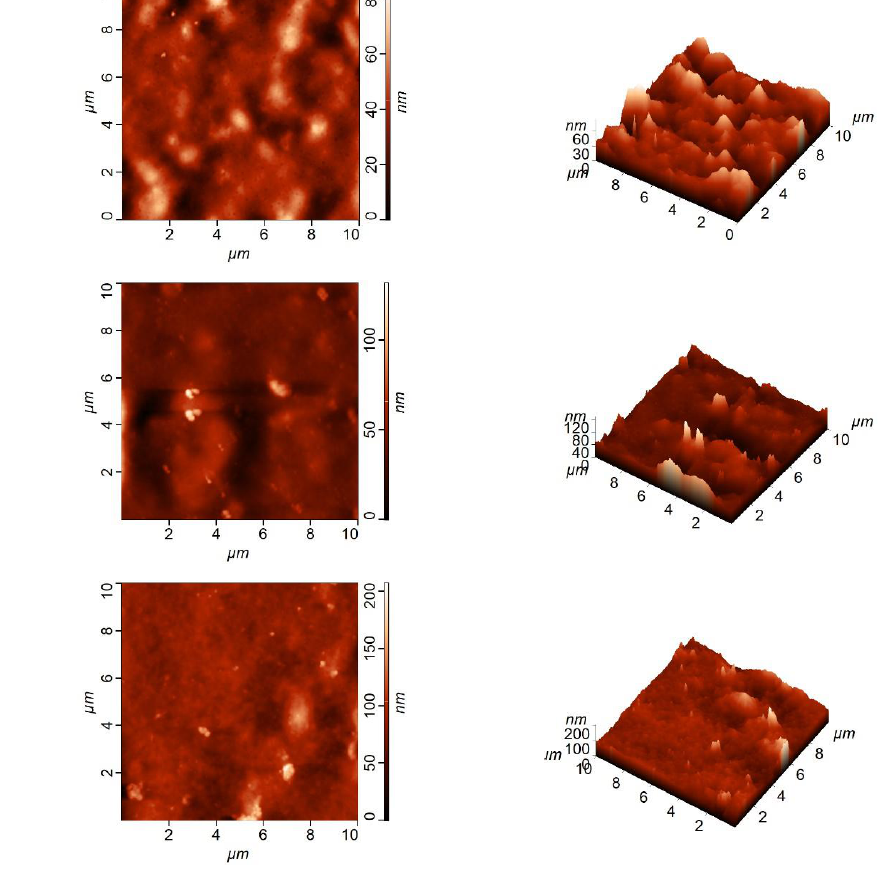
Figure 7. AFM images of the surface of the selective layer of TFC and TFN membranes prepared using dynamic technique.